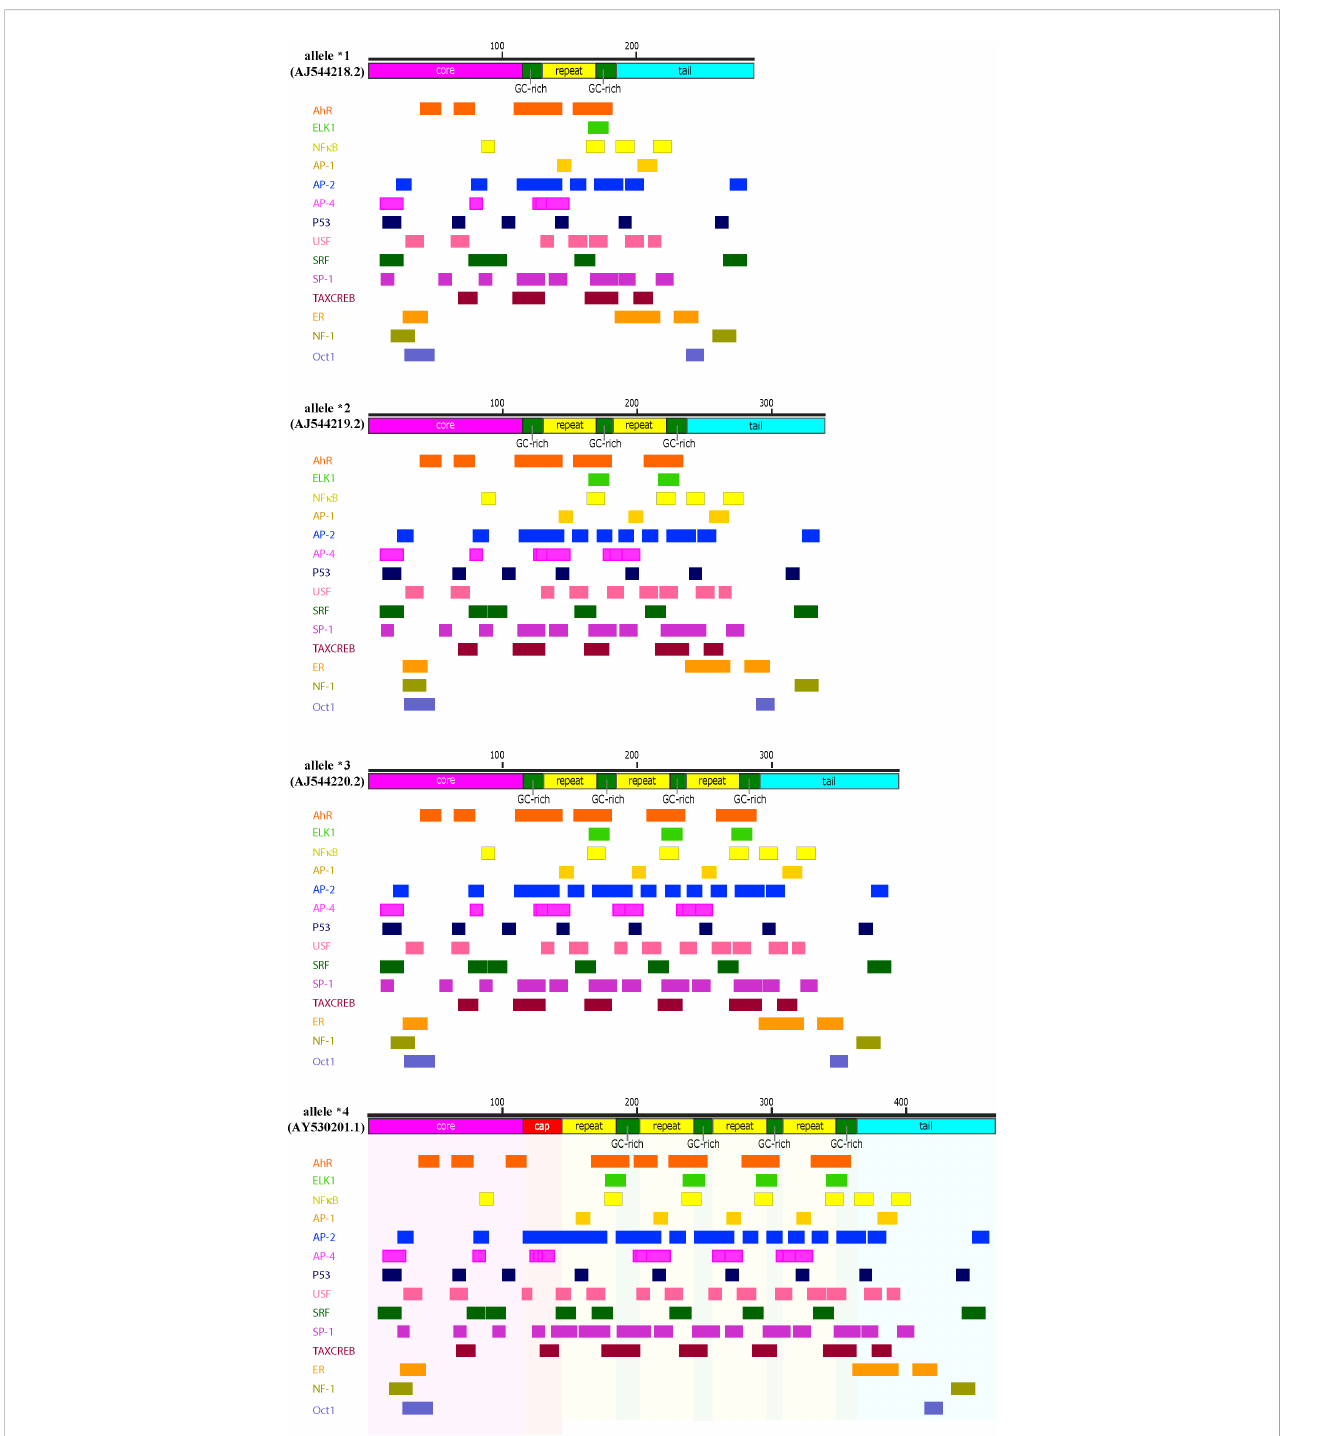
FIGURE 7 Transcription factor consensus binding sites within the human hs1.2 enhancer alleles. Depicted are the four known alleles of the human hs1.2 enhancer, which differ mainly in the copy number ( “ repeat ” ) of the internal 40 bp monomer. A “ core ” (magenta) and a “ tail ” (light blue) sequence are common to all the variants, while the yellow box ( “ repeat ” ) may be present from one to four times in human. However, at present, the highest copy number has been detected in the chimpanzee hs1.2 enhancer, which has twelve repeats. The green boxes are GC-rich regions. The red “ cap ” box is a GC-rich region longer than the ones indicated by the green boxes. The alleles were analyzed in silico for potential transcription factor binding sites using TFBIND (https://tfbind.hgc.jp/). The consensus binding sites for several transcription factors were identi fi ed and reported below each allele. Multiple partially overlapping sites for the same transcription factor were merged and depicted as a single larger box (See Supplementary File S2 for unabridged depiction of consensus binding sites of the allele *4). Consensus sites mapping in the hs1.2 “ repeat ” generally change in copy number according to the number of monomers, thus potentially making the enhancer alleles differentially receptive to transcription factors. Moreover, each copy of the monomer harbors a region that could form a quadruplex DNA 3-D structure (see Figure